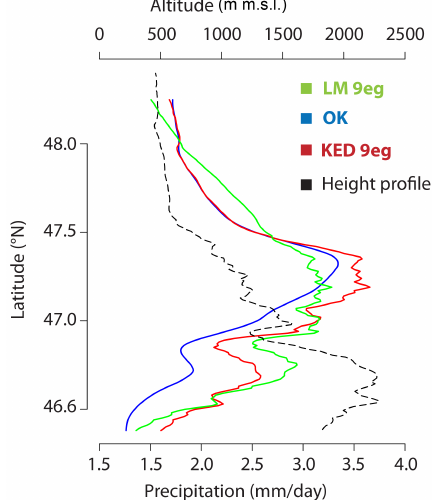
Figure 5. North–south precipitation profile as estimated by the three interpolation methods LM9eg, OK, and KED9eg (see Table 1). DJF long-term mean precipitation (lower x axis, mmday − 1 ) serves as a function of latitude ( y axis, ◦ N). The dashed line indicates the height profile (upper x axis, m) as a function of